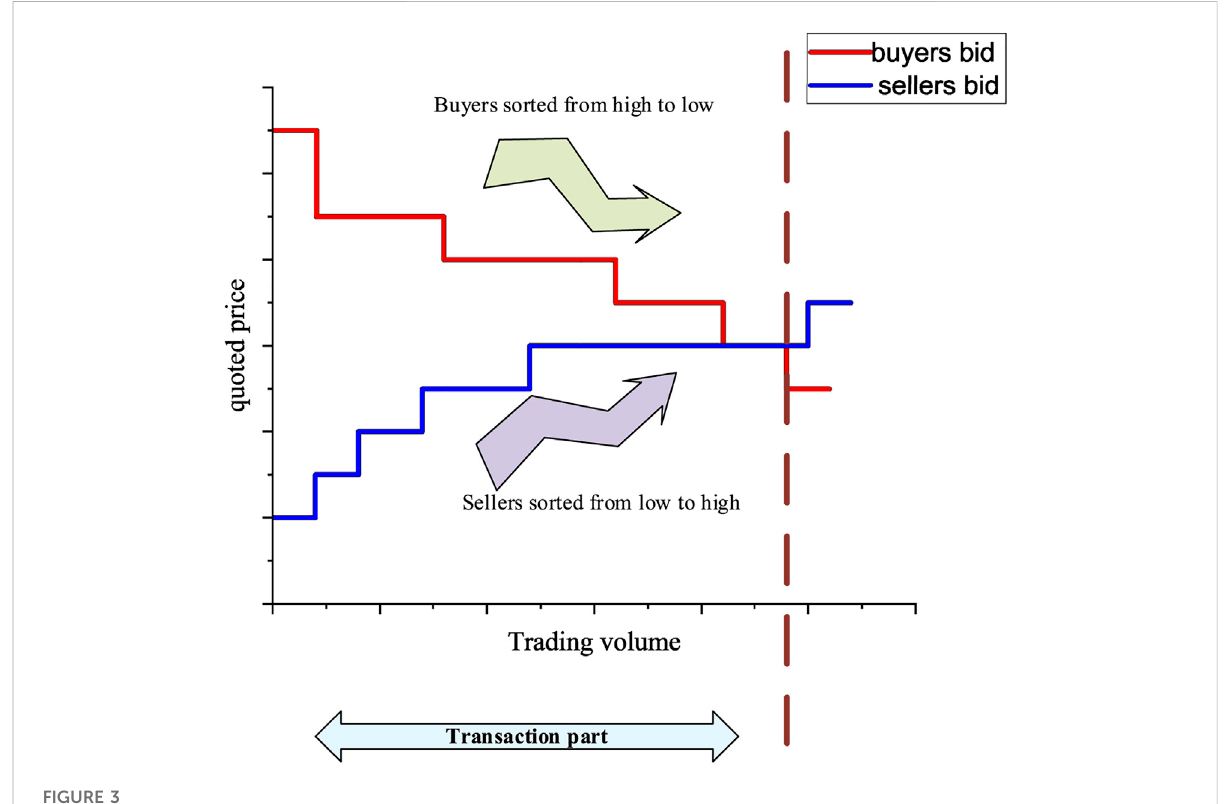
FIGURE 3 Bilateral bidding